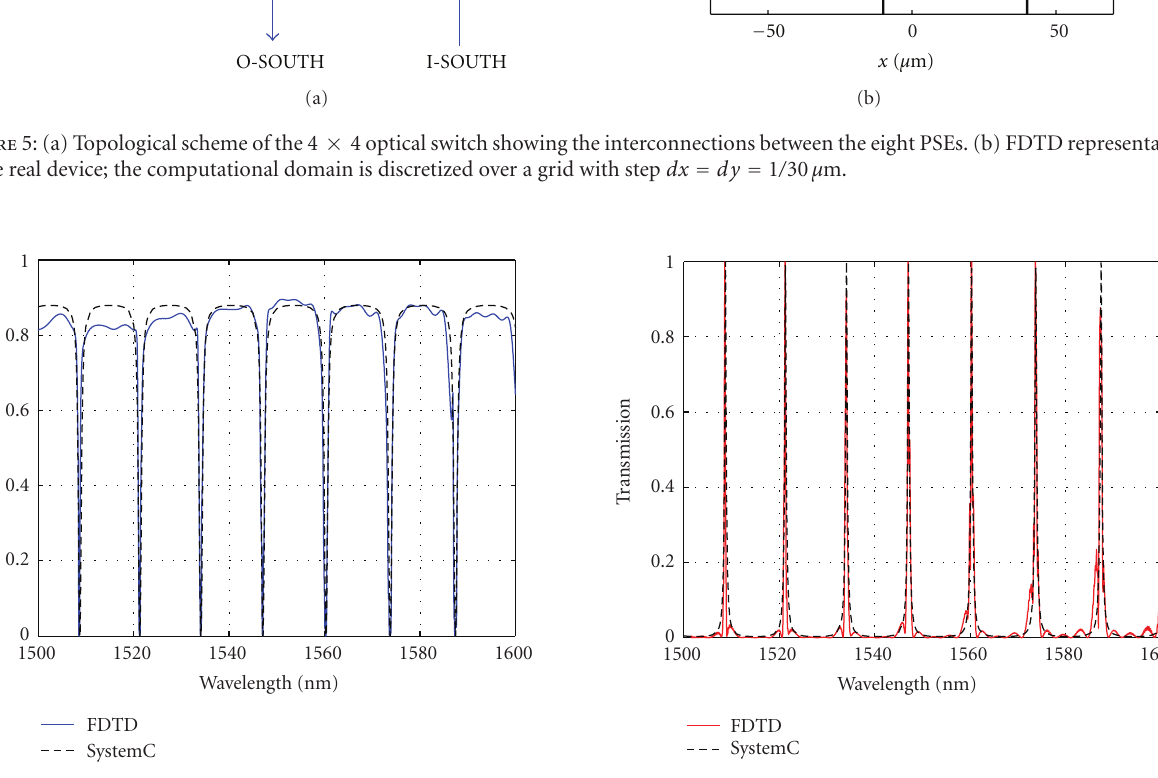
Figure 6: Simulated (solid line) and modeled (dashed line) transmission curves for the path linking the I-WEST port with the O-NORTH port of the 4 × 4 optical switch.